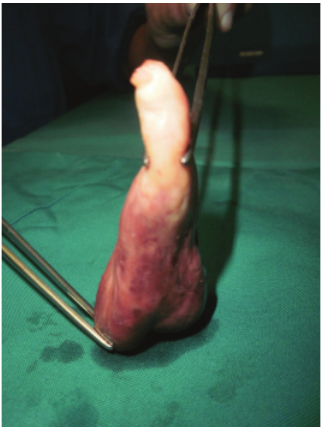
Figure 1: Giant aortic fibroelastoma.